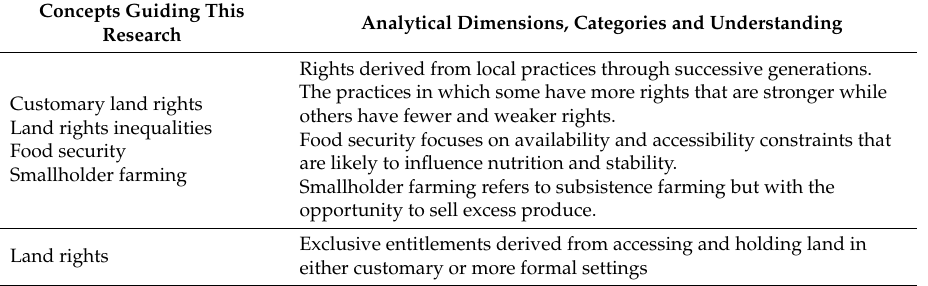
Table 3. Analytical